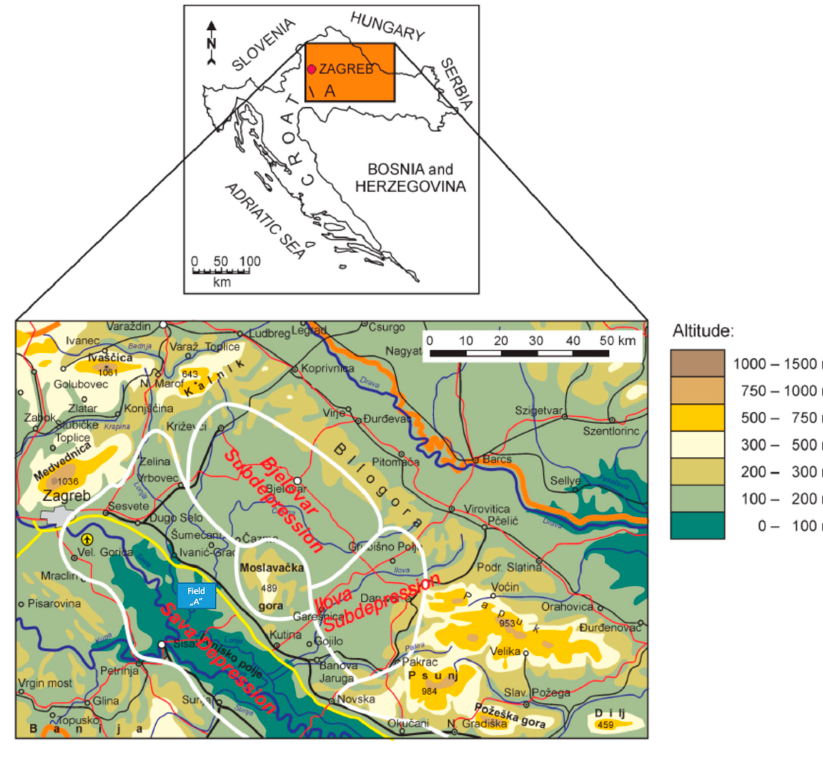
Figure 2. Location of the analyzed area [22]. Geosciences 2018 , 8 , x FOR PEER REVIEW